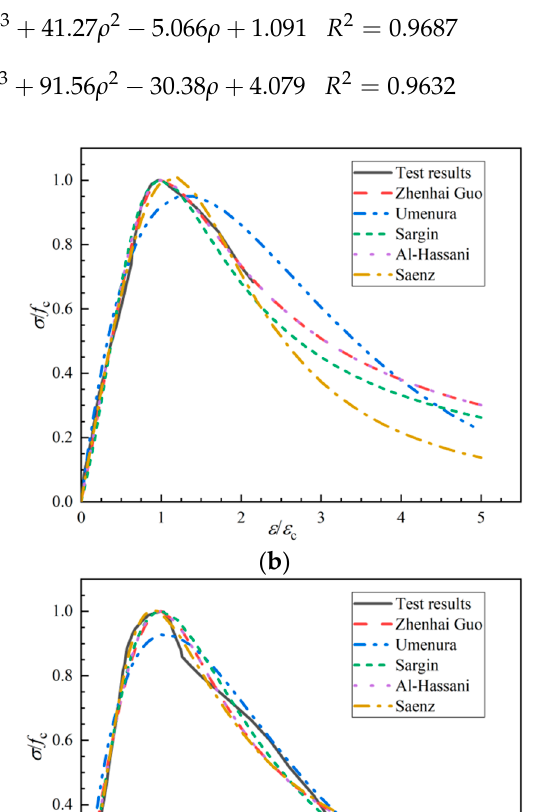
According to Equations (13), (18), and (19), the complete stress–strain curve of SWSSC with any POM fiber content could be determined.